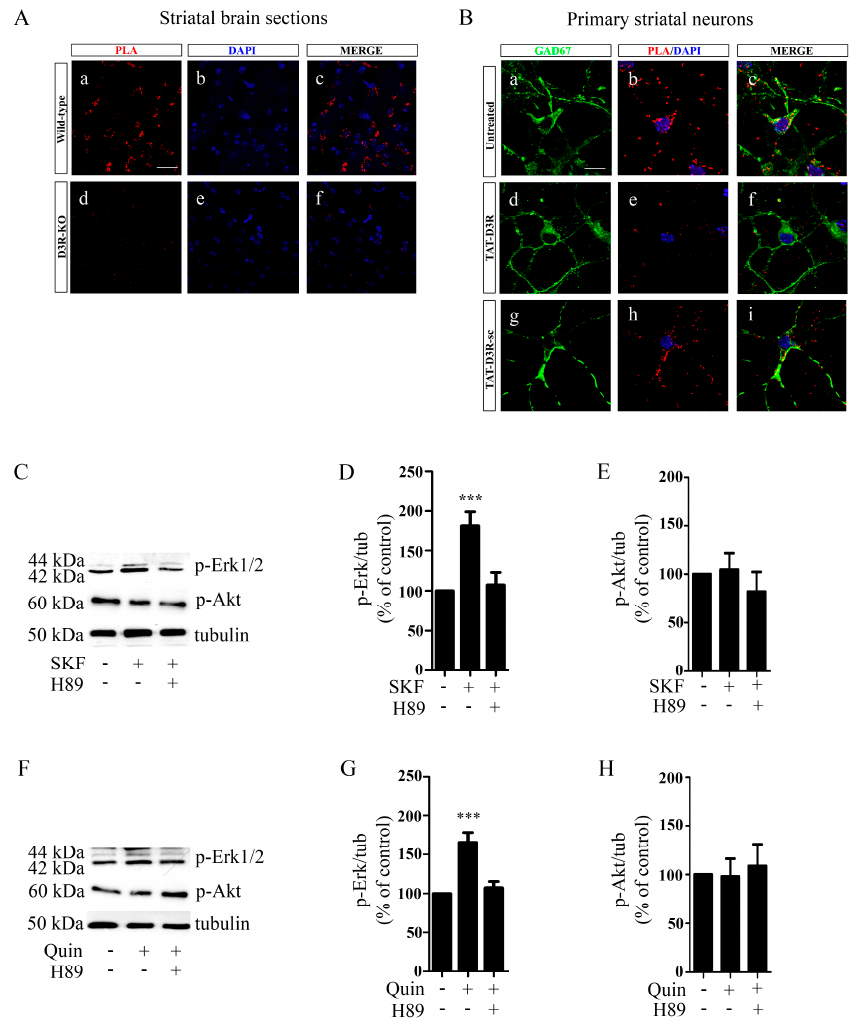
Figure 6. In mouse primary striatal neurons expressing the D1R/D3R heterodimer, D1R and D3R individual stimulation promotes the activation of the PKA-Erk1/2 pathway. (( A ) Representative PLA image performed in striatal brain sections from Wild-type ( a – c ) and D3R-KO mice ( d – f ), using antibodies against D1R and D3R; positive PLA signals appear as red spots and nuclei are detected with DAPI. Scale bar: 100 μ m. ( B ) Representative PLA image performed in mouse primary striatal neurons untreated (panel a – c ) and pre-treated with TAT-D3R (1 μ M) (panel d – f ) or TAT-D3R-sc (1 μ M) (panel g – i ) for 24 h; specific anti-D1R and anti-D3R antibodies were used. Striatal neurons were detected using the anti-GAD 67 antibody; PLA signals appear as red spots; nuclei are detected with DAPI (blue). Scale bar = 20 μ m. ( C ) Mouse primary striatal neurons were exposed to SKF (10 μ M; 5 min) in the presence or in the absence of H89 (1 μ M) added 30 min before SKF challenging and analyzed for p-Erk1/2 and p-Akt using WB; a representative WB is shown. ( D , E ) Densitometric anal- ysis of blots with specific p-Erk1/2 and p-Akt levels normalized to the corresponding tubulin levels. Bars represent the mean ± S.E.M. *** p < 0 . 001 vs untreated cells (n = 6) ( F ) Mouse primary striatal neurons were exposed to the Quin (10 μ M; 5 min) in the presence or in the absence of H89 (1 μ M) added 30 min before Quin challenging and analyzed for p-Erk1/2 and p-Akt using WB; representa- tive WBs are shown. ( G , H ) Densitometric analysis of blots with specific p-Erk1/2 ( G ) and p-Akt (H) levels normalized to the corresponding tubulin levels. Bars represent the mean ± S.E.M. *** p < 0 . 001 vs. untreated cells (n = 6). Data were statistically analyzed using one-way ANOVA followed by post hoc comparison with the Bonferroni test.